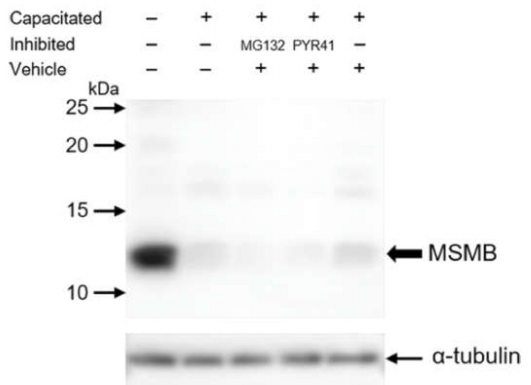
Figure 4. Western blot detection of porcine MSMB with specific polyclonal anti-MSMB antibody in the protein extracts from ejaculated and IVC spermatozoa under non-inhibiting, proteasomally-inhibited (100 µ M MG132), and E1-inhibited conditions (50 µ M PYR41), also including vehicle control (DMSO). The black arrow indicates the expected immunoreactive band of MSMB of approximately 12 kDa. Equal protein loads were confirmed by monoclonal antibody anti- α -tubulin DM1A. SDS-PAGE was run under reducing conditions and the experiment was replicated four times, see Figure 5 for densitometric quantification.